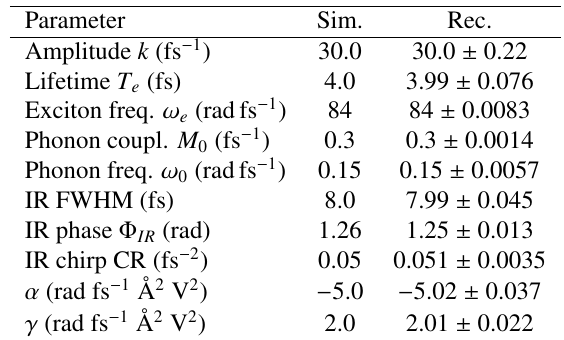
Table 1. Simulated and reconstructed parameters, defining the exciton, its interaction with the phonons and with the IR